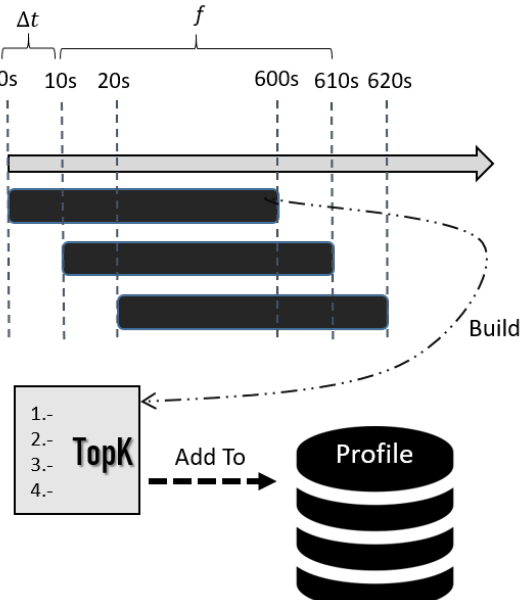
Figure 5. Depicting timeframe overlapping in the profile building